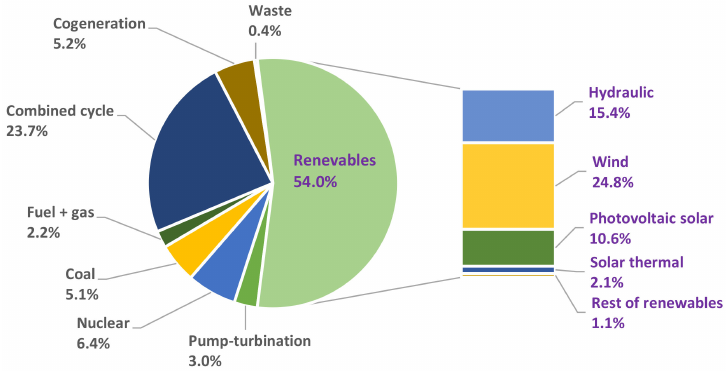
Figure 1. Renewable energies in the Spanish electrical system 2020